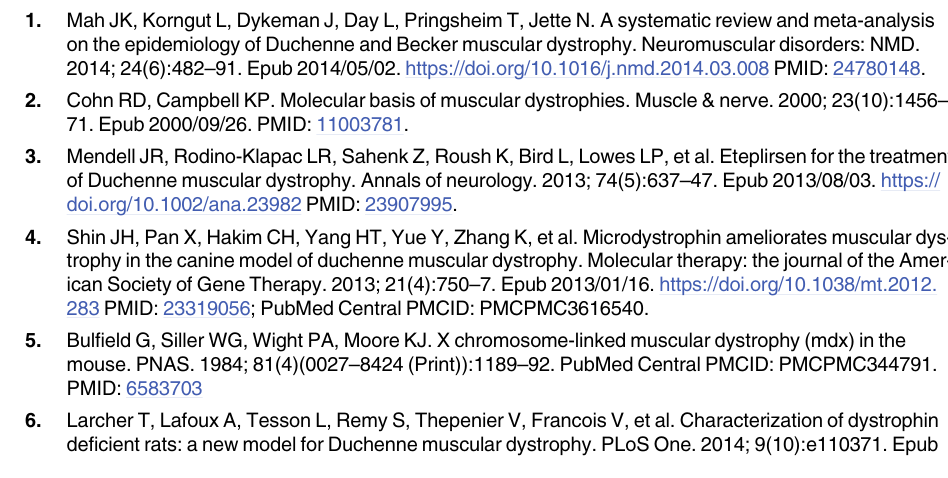
S8 Table. Correlation matrix of RQ values. Spearman’s Rho values for RQ correlations (all genes). Bold: correlations between high scoring candidates (ACTB, RPL13a, CSNK2A2, AP3D1). Italics: correlations with P values greater than 0.0001 (all other